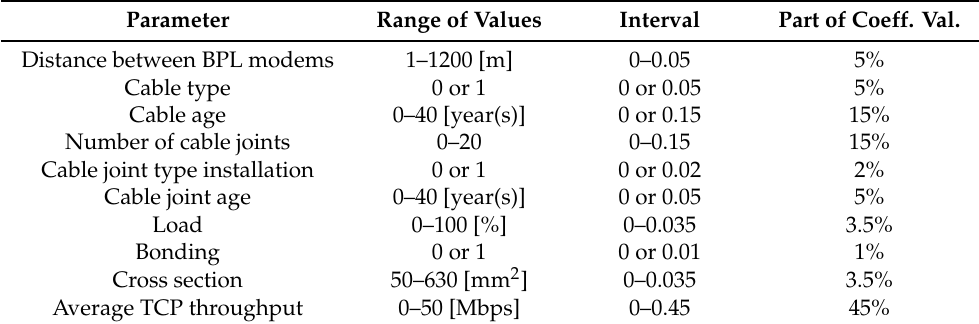
Table 2. Rating of individual parameters of the cable health on the MV network. Parameter Range of Values Interval Part of Coeff.